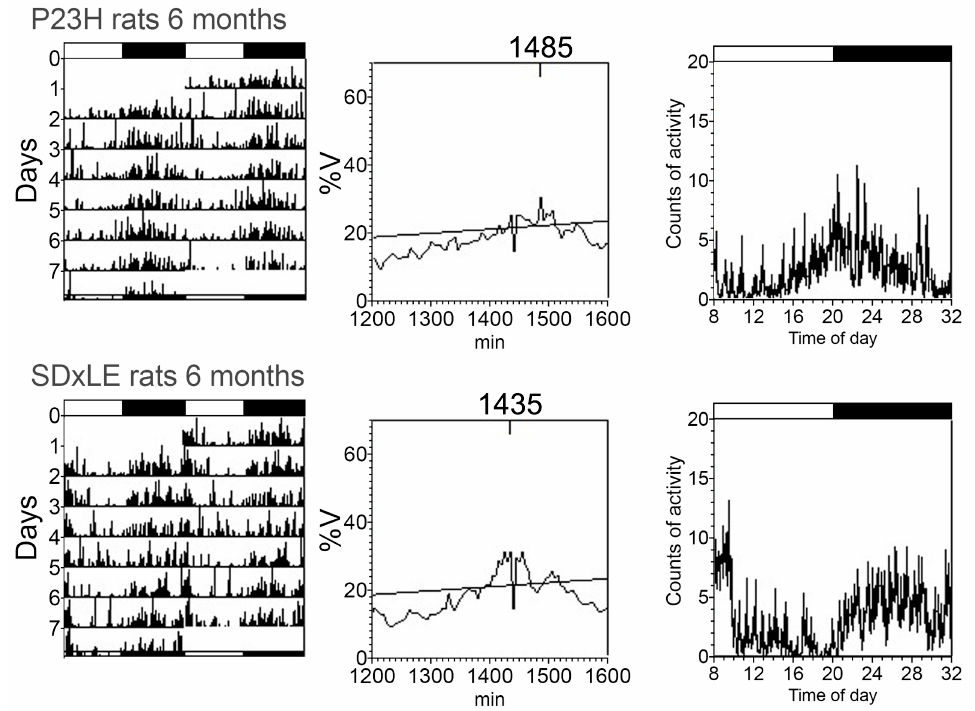
Figure 6. Representative actograms (left), periodograms (middle), and mean waveforms (right) obtained analyzing locomotor activity rhythms at P180 in P23H and SD × LE rats with epigallocatequin gallate (EGCG) treatment. The light/dark cycle is represented by white and dark horizontal bars, respectively.